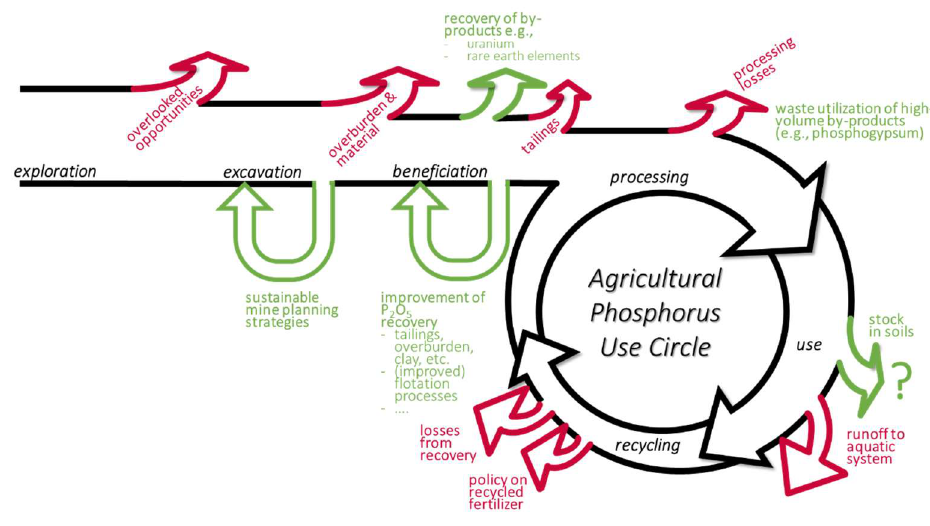
Figure 3. Circular principles for moving toward a circular phosphorus economy.